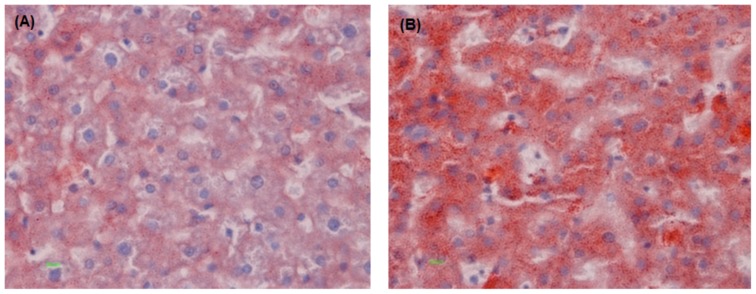
Representative photomicrographs of livers from hamsters after 12 weeks.(A) with microencapsulated L. fermentum ATCC 11976 treatment and, (B) without treatment. Microencapsulated L. fermentum ATCC 11976-supplemented animals (A) show lesser fat infiltration in the hepatocytes whereas, control animals (B) are filled with 30% greater micro-vesicular fat deposits (Oil Red O, 400X).